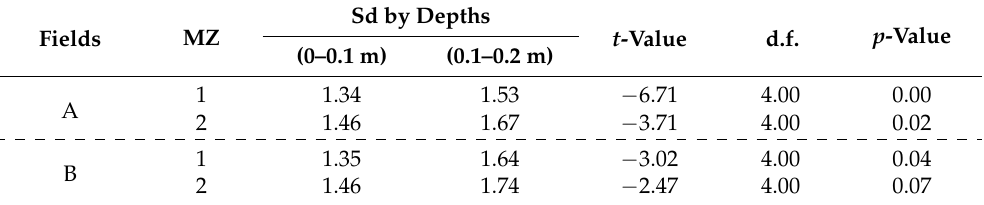
Table 5. Soil bulk density (Sd; g cm − 3 ), in two fields (A and B), and two depths (0–0.10 m and 0.10–0.20 m) in management zones delineated based on apparent electrical conductivity. Cachoeira do Sul, RS,